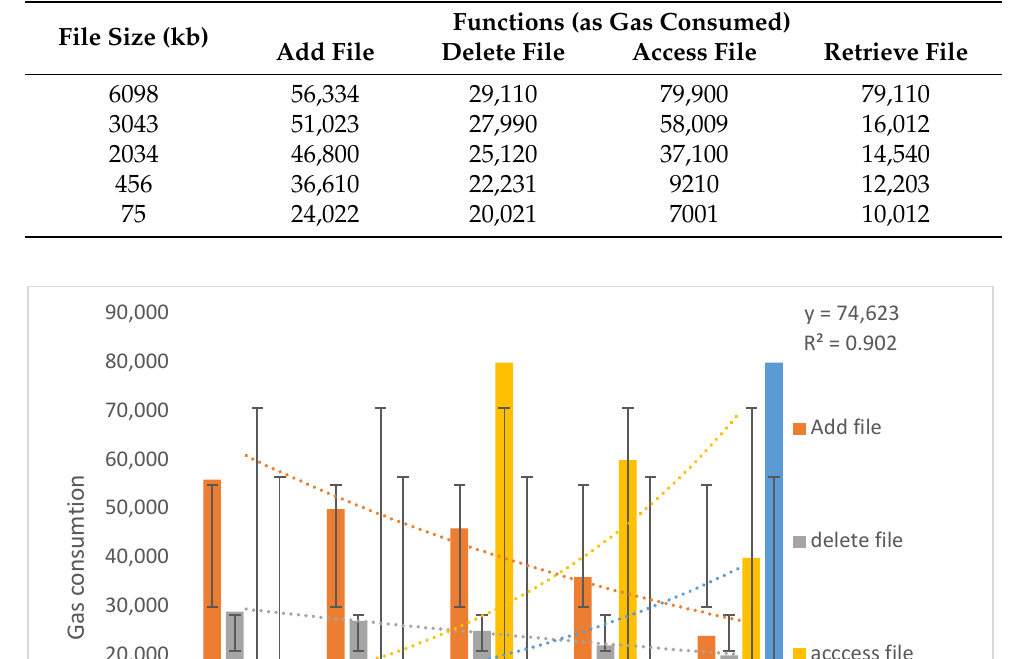
Table 4. Gas consumption cost to add, delete, access and retrieve files.